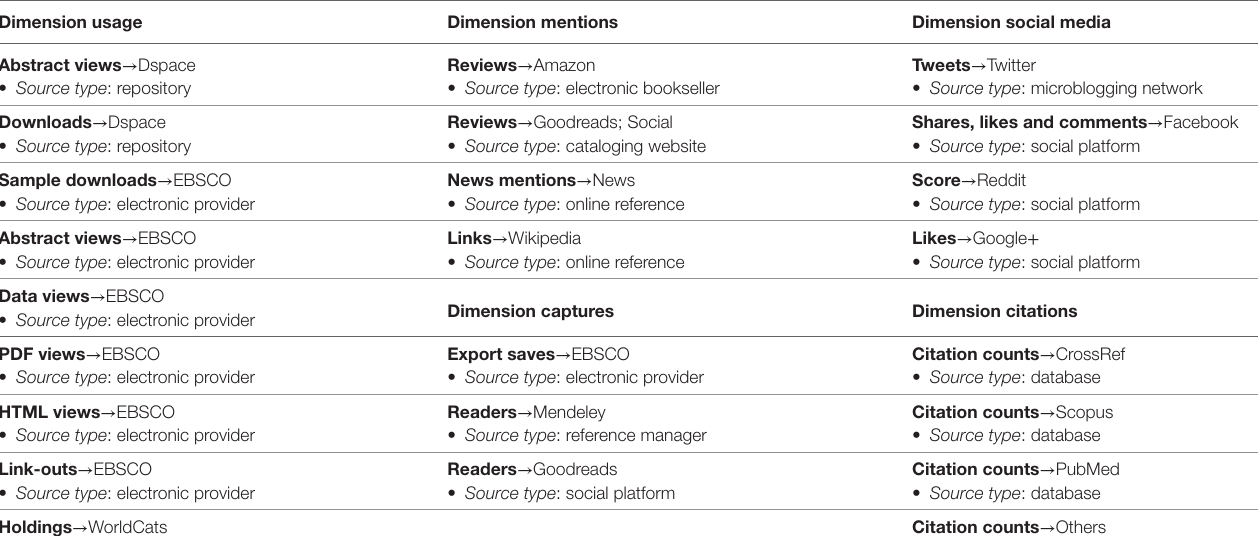
TaBle 1 | Measures gathered in PlumX classified according to their dimension and